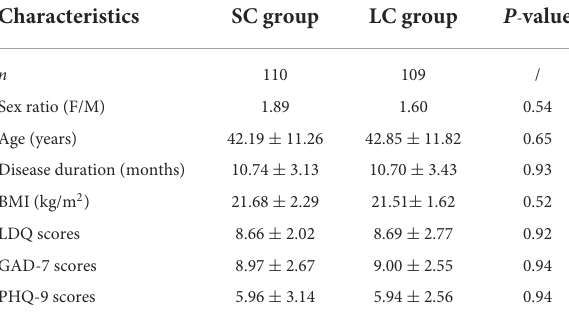
TABLE 1 Demographic and baseline clinical characteristics of the enrolled patients with refractory functional dyspepsia in per-protocol